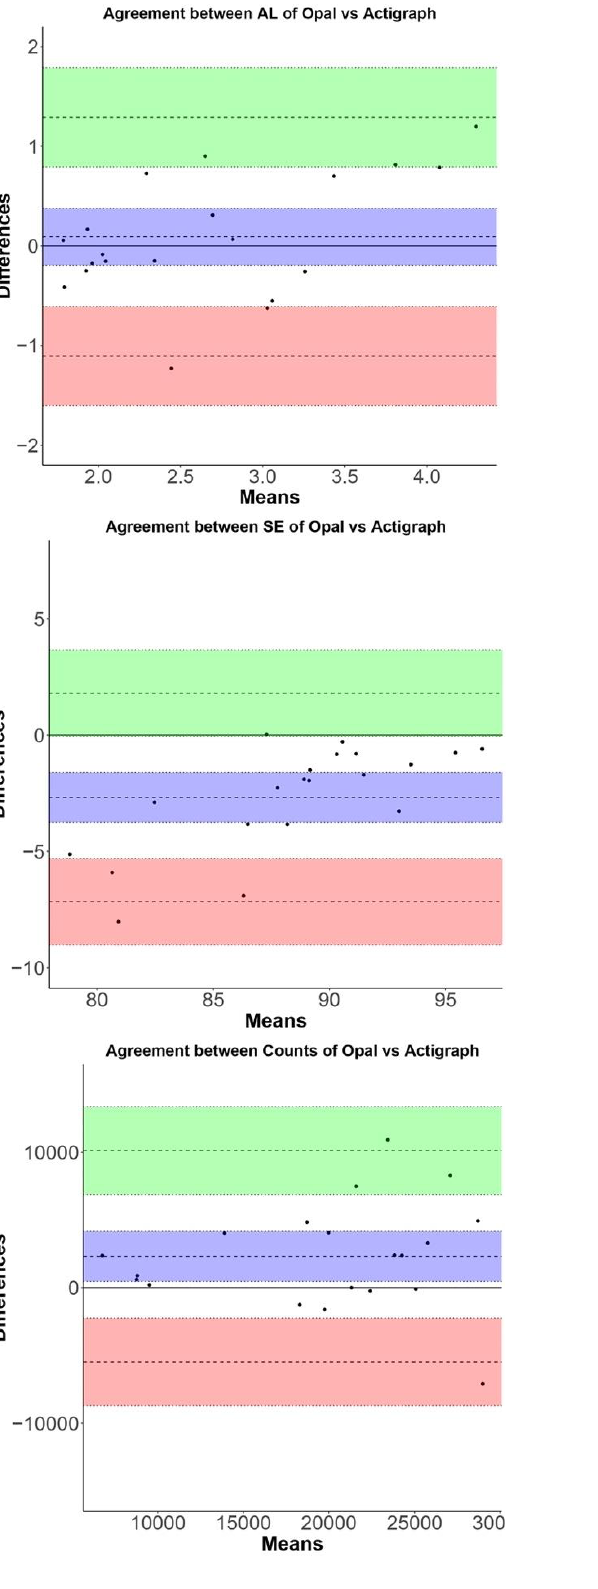
Figure 4. Bland – Altman plots of sleep measures. Figure 4. Bland–Altman plots of sleep